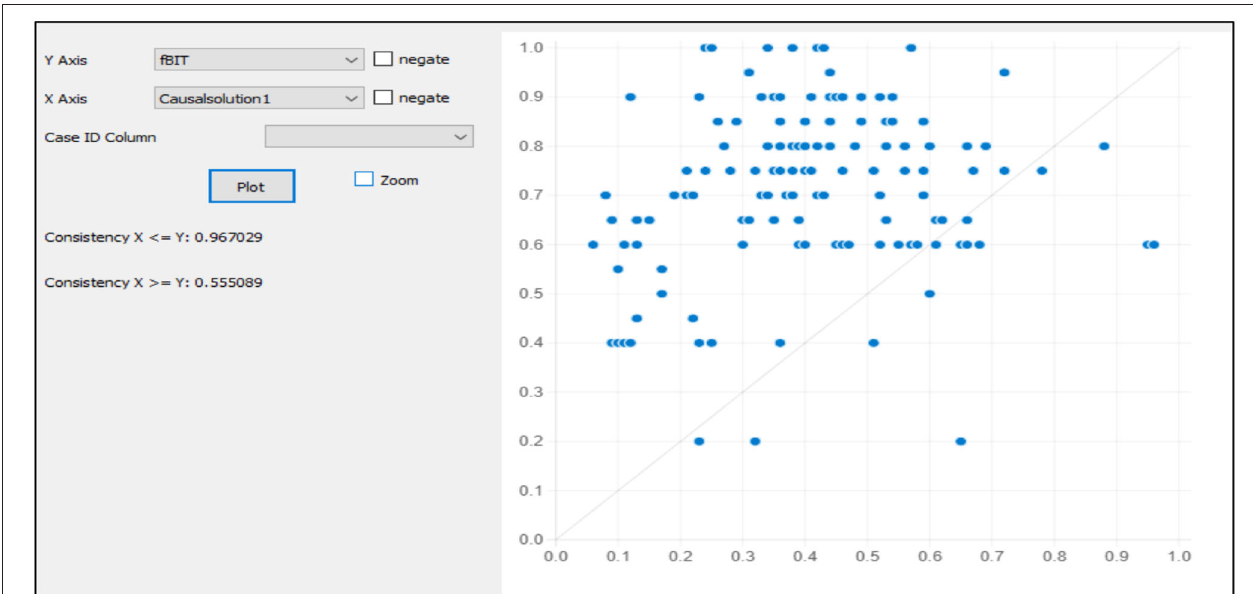
FIGURE 2 | Fuzzy plot for model 1 within holdout sample.